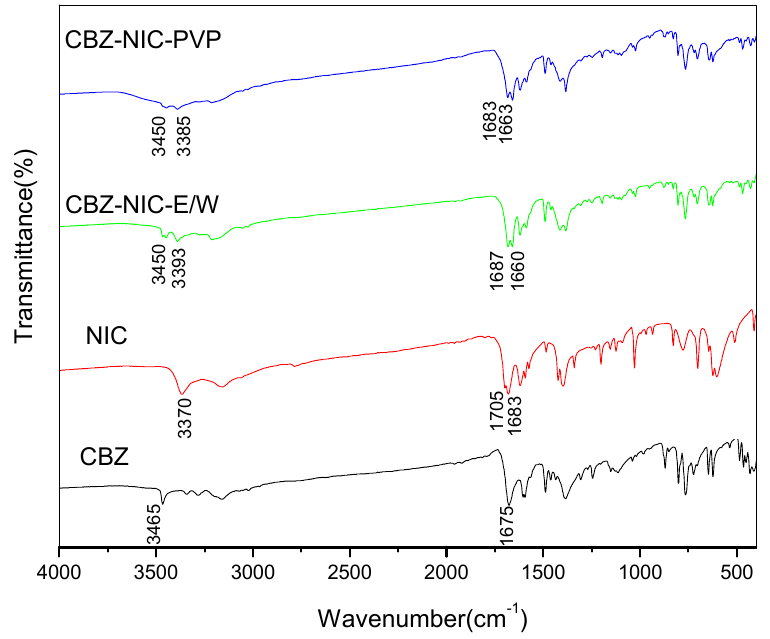
Figure 2. Infrared spectroscopy (IR) spectra of carbamazepine (CBZ), Nicotinamide (NIC), CBZ-NIC cocrystal screening product prepared in ethanol-water mixture (CBZ-NIC-E/W) and in polyvinyl pyrrolidone solution (CBZ-NIC-PVP).